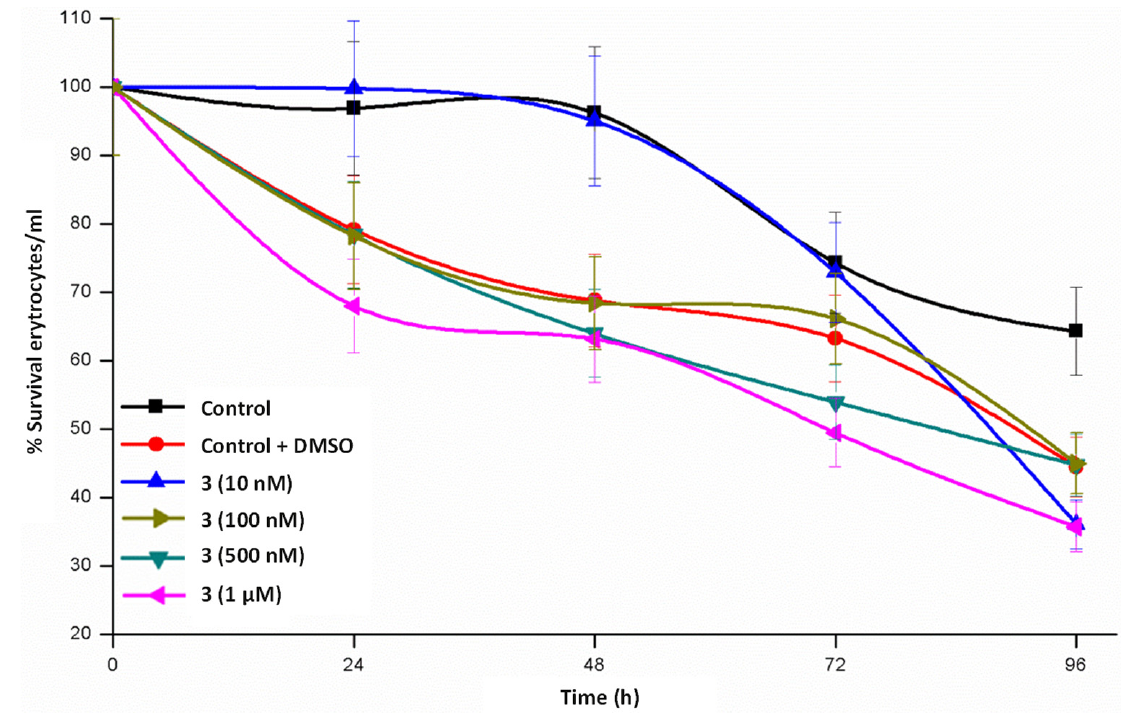
Figure 6. Time course study of erythrocyte survival in the presence of Zn 2 (L PhNO2 ) 2 3 dihelicate.